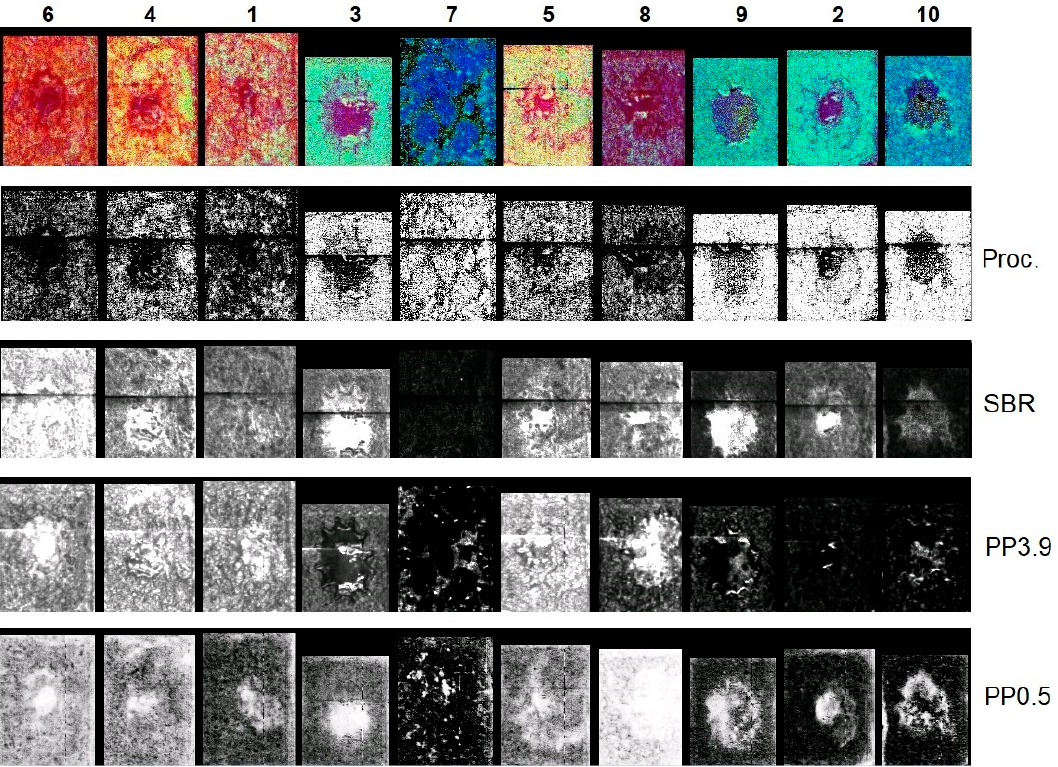
Figure 14. Froth imagery of sample suite #1 (10 samples) converted to predicted values using the models described in Section 4.2: processability (Proc.), solids to bitumen (SBR), %pp3.9, and %pp0.5. These are displayed as a grey tone scale with brightest values corresponding to the highest predicted values. The reader should discard the near circular central region of each image where removal of the impeller has largely removed the froth. Additionally included for reference are the sample # and the color composite of froth imagery in continuum removed reflectance (red = 1750 nm, green = 2167 nm, blue = 2205 nm) presented in Figure 9.